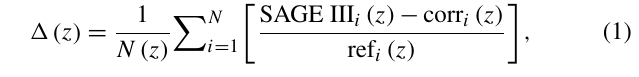
Figure 5. Similar to Fig. 2 but for the average difference of coin- cident pairs for SAGE III-ISS and Lauder ozonesonde profiles ob- tained from June 2017 to May 2018.